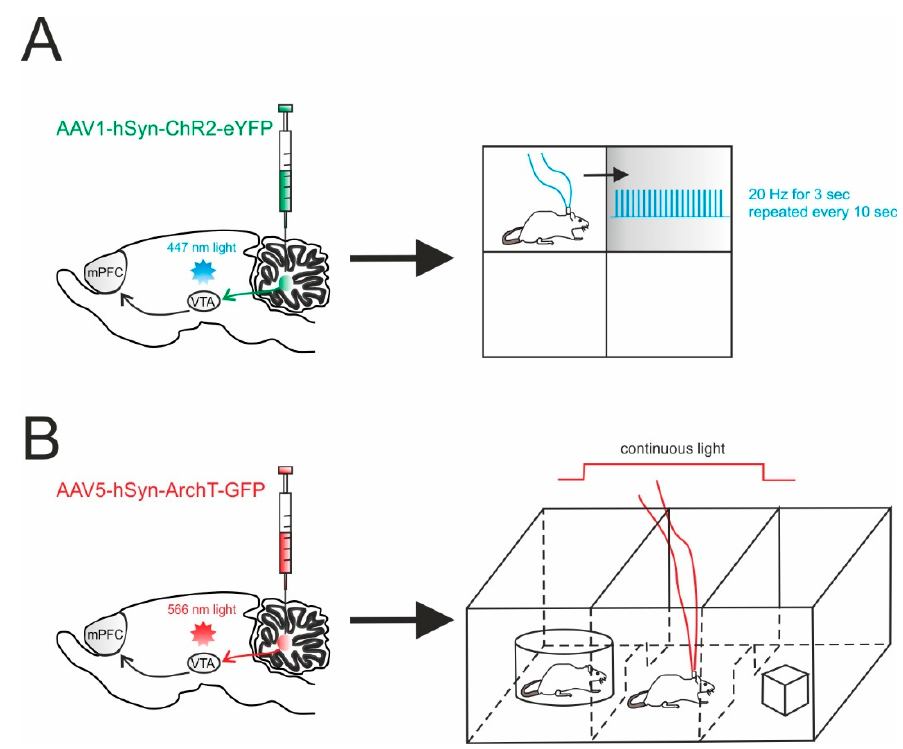
Figure 3. Cerebellar influence on reward and sociability. ( A ) Left , schematic viral injection of AAV1-hSyn-ChR2-eYFP targeting the deep cerebellar nuclei (DCN). Optical fibers were implanted into the ventral tegmental area (VTA), bilaterally. Right , mice were allowed to explore a square chamber, divided in quadrants, one of which was associated to a reward. Whenever the mouse entered in the reward quadrant, cerebellar axons innervating the VTA were optically stimulated. For the time the mouse spent in the reward quadrant, the stimulus (20 Hz for 3 s) was repeated every 10 s. ( B ) Left , AAV5-hSyn-ArchT-GFP was injected in the DCN in order to selectively inhibit cerebellar axons through bilateral optical fibers implantation into the VTA. Right , Social preference was examined using a three-chambered social task. The tested mouse was allowed to approach a “stimulus” mouse confined to one side chamber (social side) or a novel object placed on the other side (non-social side). On the first day (training day), the mouse was allowed to freely explore all three chambers. On the subsequent day, the cerebellar axons innervating the VTA were optically inhibited for the time the mouse stayed by the social side. The optogenetic stimulation was immediately ceased when the mouse exited the social side.